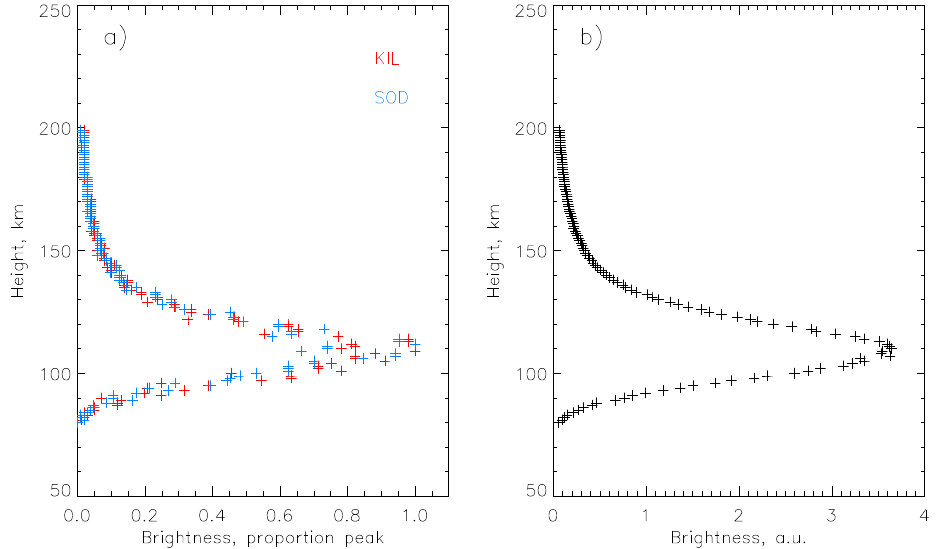
Fig. 3. (a) Altitude profile extracted from the field line highlighted in Fig. 2 for Kilpisj¨arvi (red) and Sodankyl¨a (blue). (b) Average over all field lines which pass the three tests. The brightness is shown in arbitrary units (a.u.).